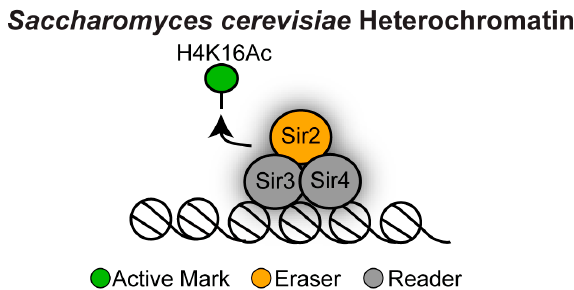
Figure 3. Heterochromatin structure differs between fungal organisms. ( A ) Phylogenetic tree of the fungal organisms discussed in this review; ( B ) presence and absence of selected writers, erasers and marks associated with heterochromatic regions in the fungal model systems Saccharomyces cerevisiae and Schizosaccharomyces pombe and in the human fungal pathogens Candida albicans , Aspergillus fumigatus and Cryptococcus neoformans . Green check: experimentally validated action of writers, erasers and marks at heterochromatic regions; Red cross: lack of orthologues/absence of marks at heterochromatic regions; and grey check: presence of orthologous genes but lack of experimental data demonstrating action of writers, erasers and histone marks at heterochromatic regions.